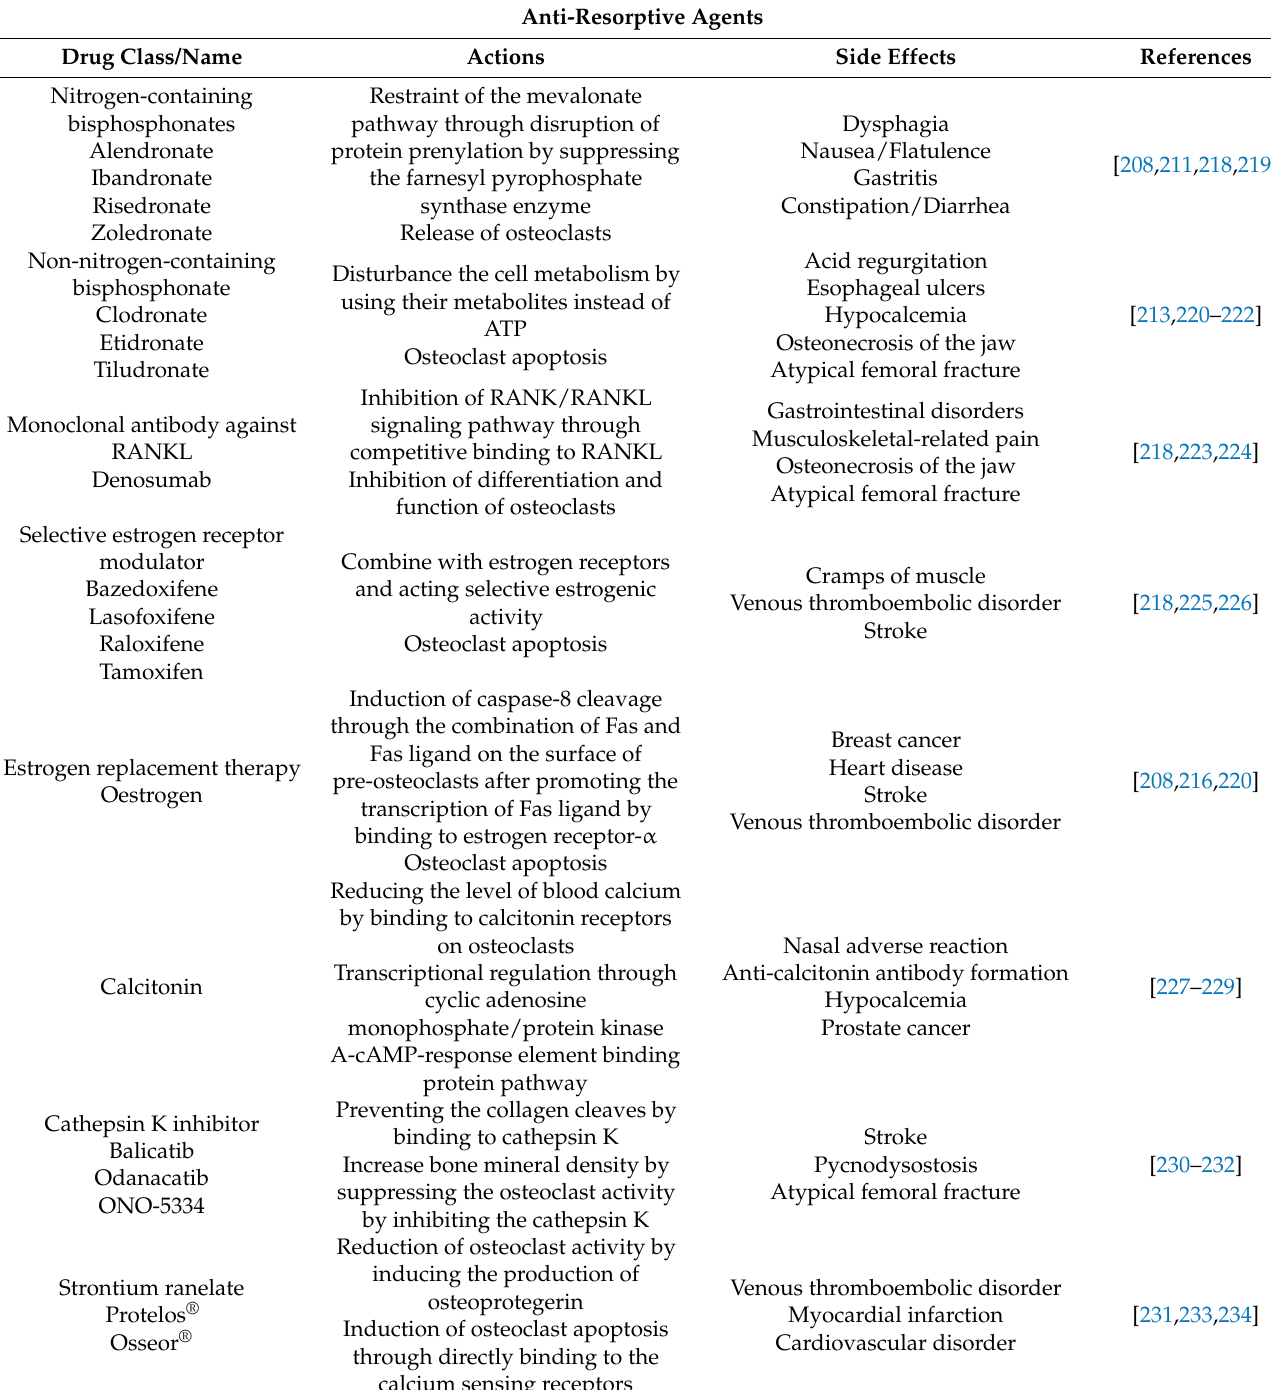
Table 2. Therapeutical options for the treatment of bone loss and their mechanisms of action and side effects. (Protelos ® and Osseor ® (Servier,